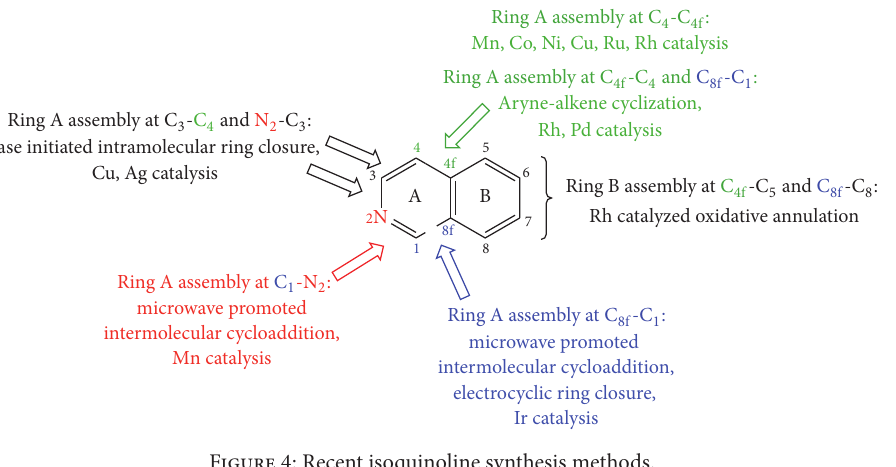
Figure 4: Recent isoquinoline synthesis methods.